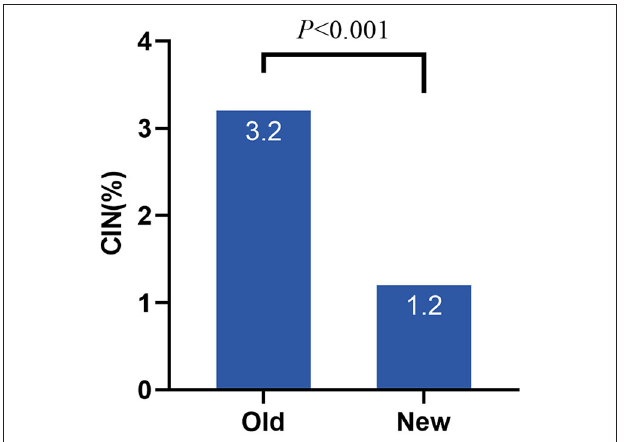
FIGURE 1 | Incidence of CIN under different criteria. CIN, contrast induced nephropathy; Old, old criteria; New, new criteria.